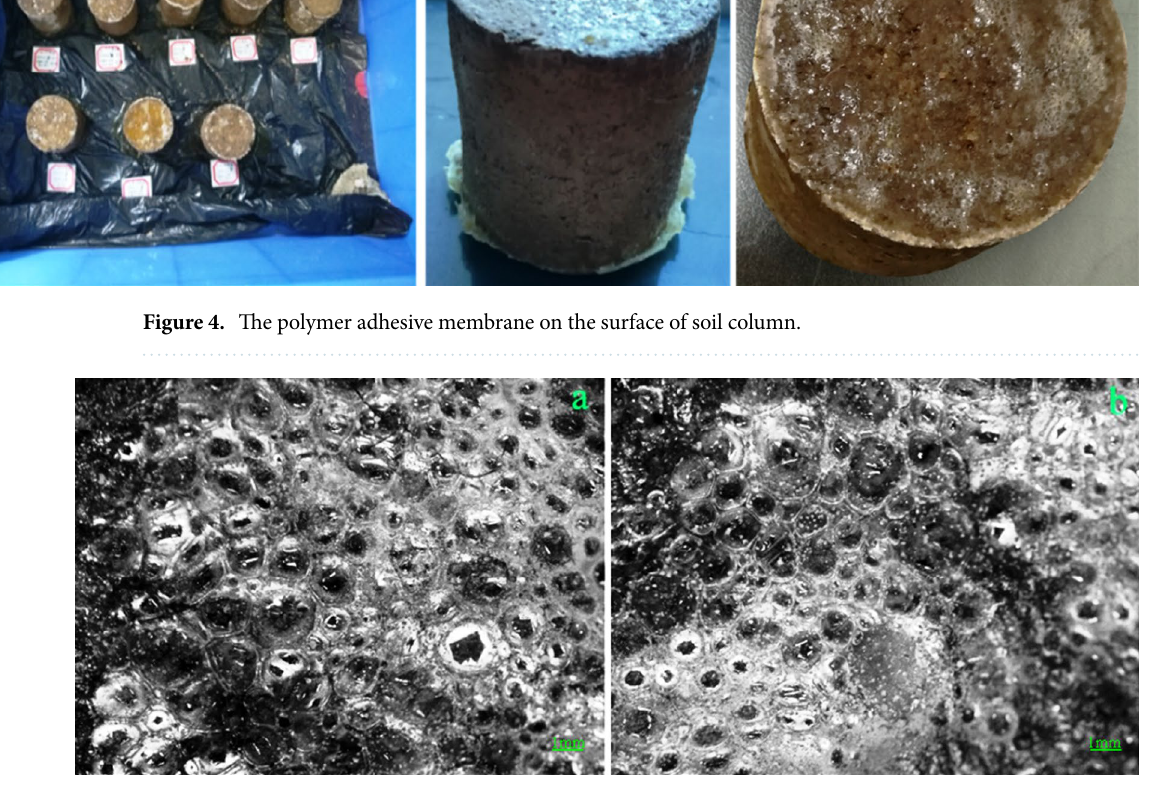
Figure 5. Cemented surface morphology of consolidated soil